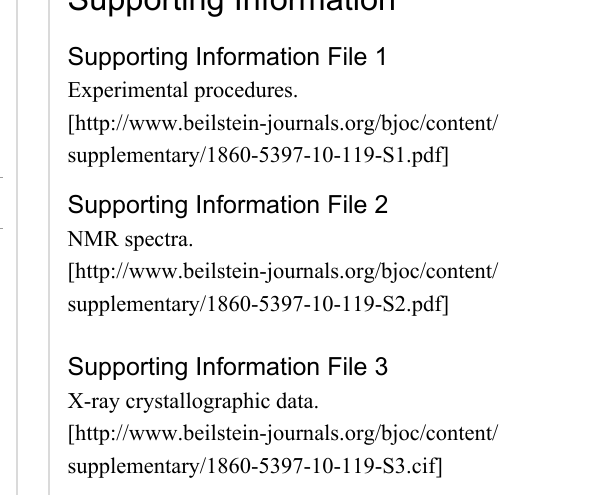
Table 3: Synthesis of